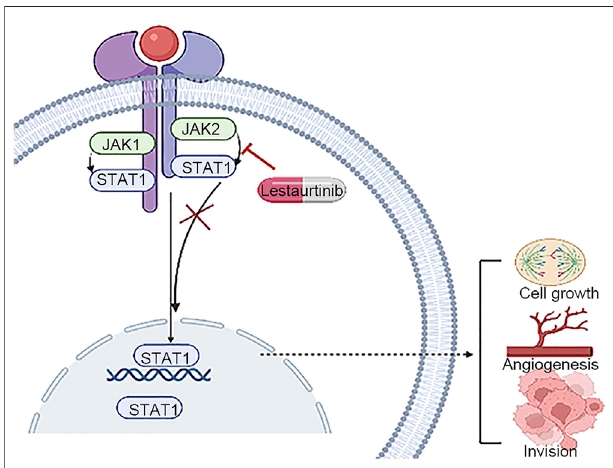
FIGURE 9 | Lestaurtinib has the potential to inhibit the proliferation of hepatocellular carcinoma.